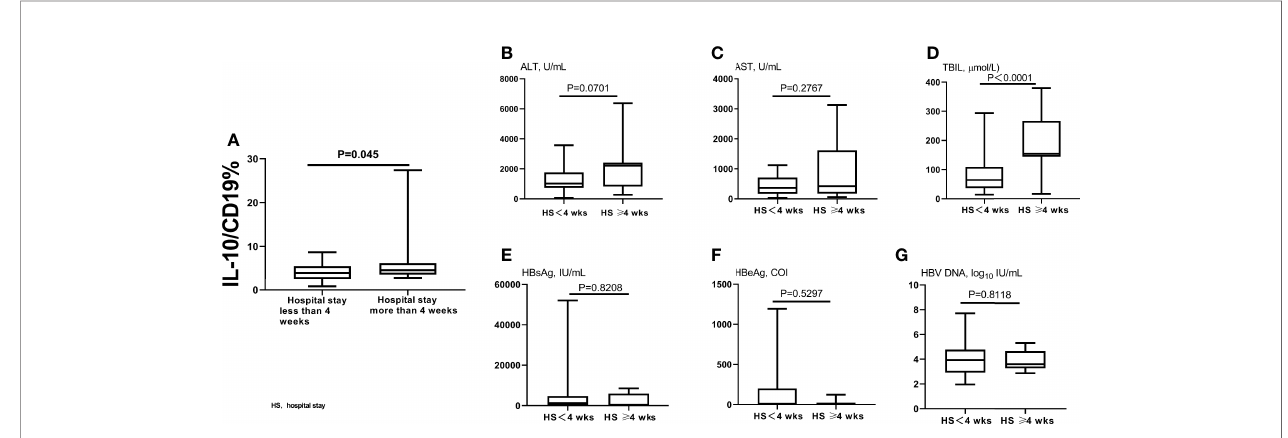
FIGURE 3 | Compared B10 levels and other liver function index between different hospitalization stay time patients. The admitting day ’ s B10 levels was signi fi cant lower in patients within 4 weeks of hospitalization stay than those of more than 4 weeks (A) . TBIL levels also show signi fi cance between the 2 groups (D) , but not ALT (B) , AST (C) , HBsAg (E) , HBeAg (F) , and HBV DNA (G)